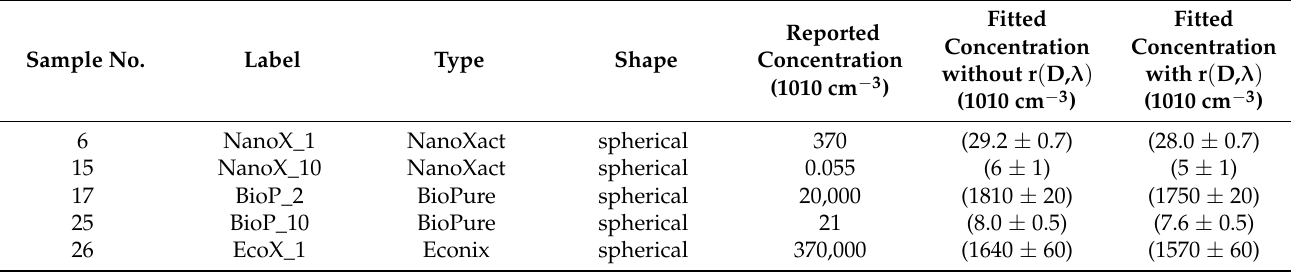
Table 4. Labels, types, shapes, reported and fitted concentrations for the same examples from Table 2 where the fitting function does not